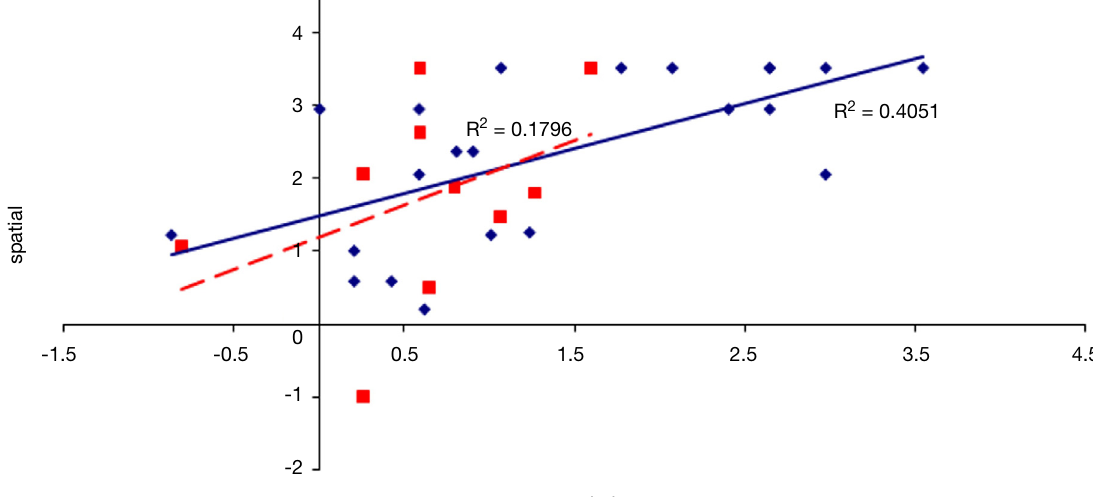
Figure 15 | Scatter plot of performance on the spatial and associative tasks with linear fi t and R -squared values for control (Experiment 1, in red squares and dashed line) and college-age (Experiment 3, in blue circles and solid line) participants. The correlation is signifi cant in college-age participants.